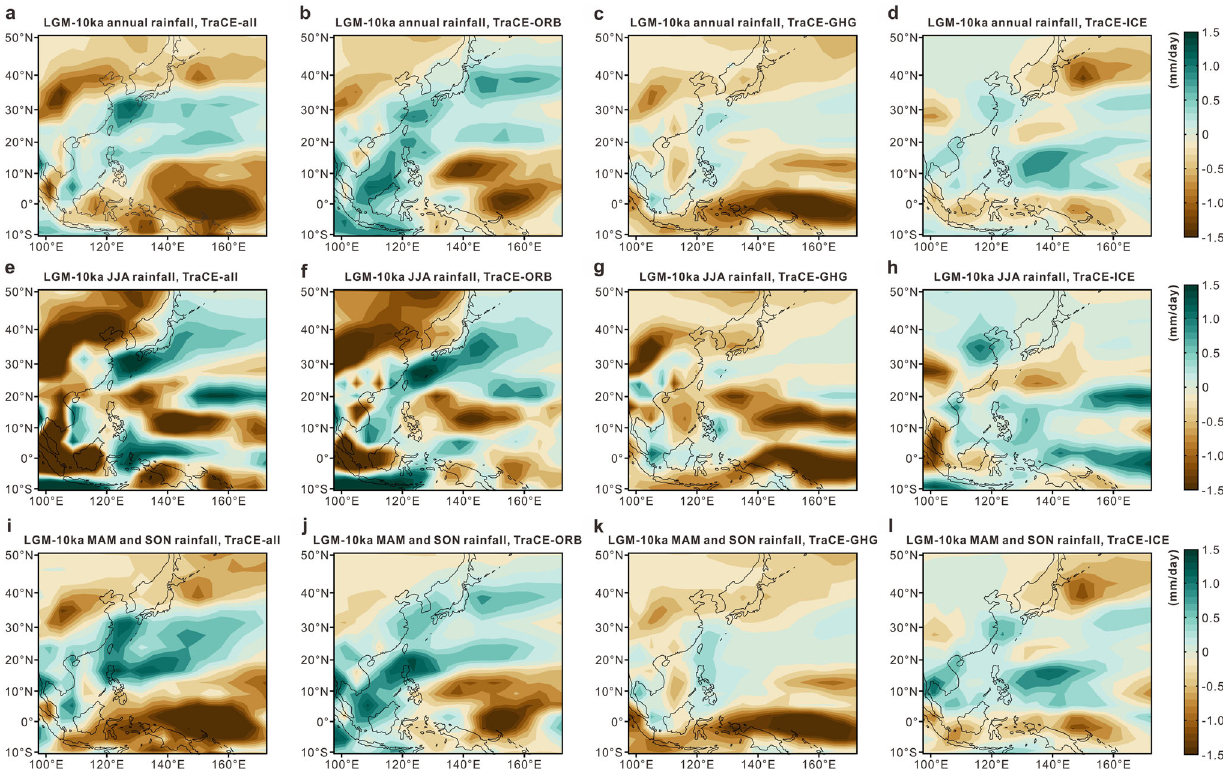
Fig. 3 Simulated seasonal rainfall differences between the LGM and 10 ka in East-Southeast Asia. a – d Annual rainfall responses to TraCE-all, TraCE- ORB, TraCE-GHG and TraCE-ICE forcings, respectively. e – h and i – l The same as a – d but for boreal summer (JJA), spring (MAM) and autumn (SON) rainfall, respectively.